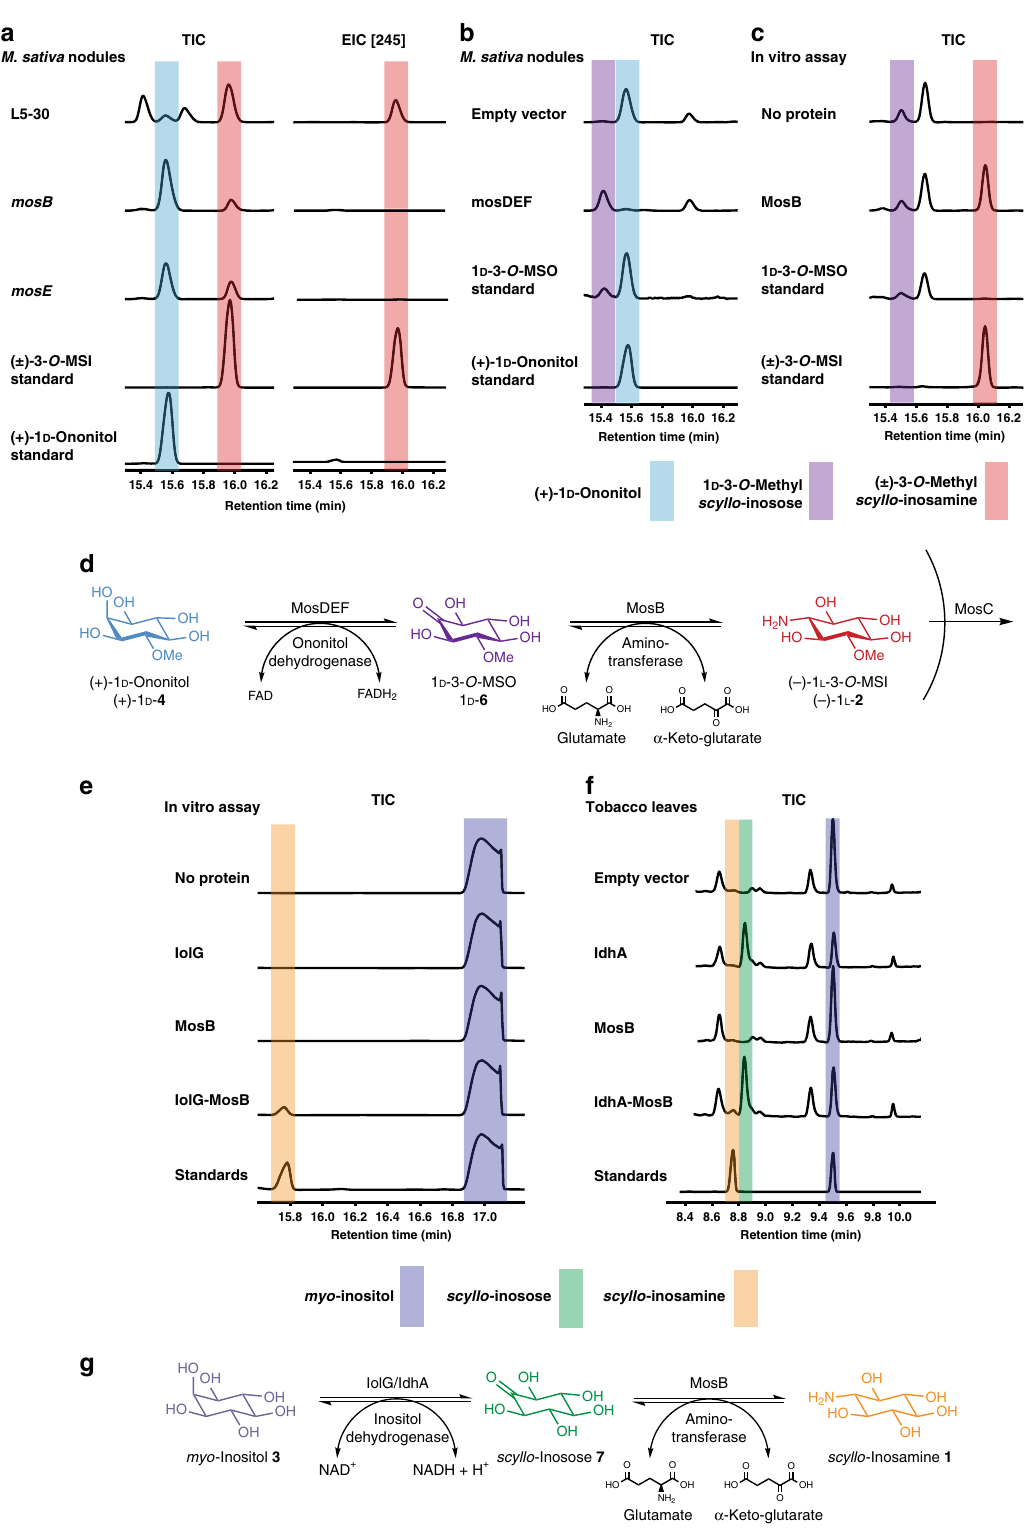
Next, MosB was puri fi ed and when incubated with chemically synthesised 3- O -methyl- scyllo- inosose (±)- 6 , the cofactor pyr- idoxal 5 ′ -phosphate (PLP), and L -glutamate, 3- O -MSI 2 was produced (Fig. 2c, Supplementary Fig. 6a). Therefore, MosB functions as a 3- O -methyl- scyllo- inosose: L -glutamate amino- transferase generating 3- O -MSI 2